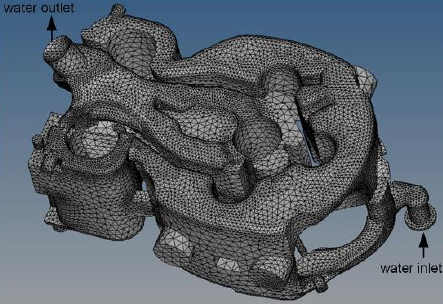
Figure 6. FE model of the cooling water jacket.